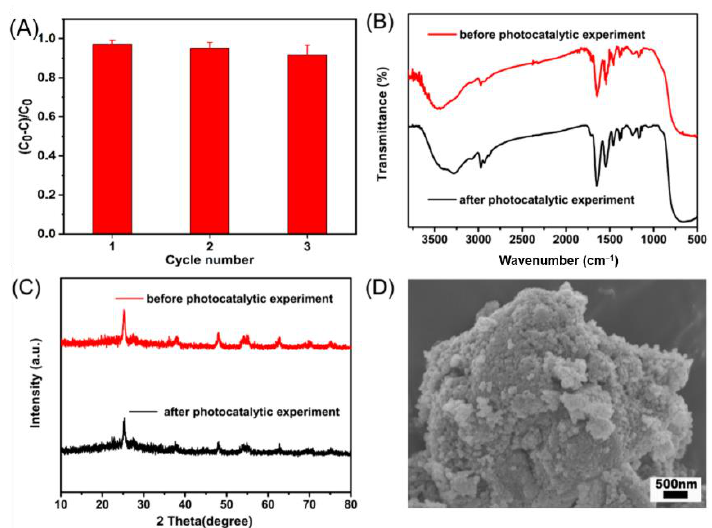
Figure 7. Photocatalytic efficiency of ZnPc- g -TiO 2 - g -PNIPAM (0.3 g/L) for the RhB (4.8 mg/L) removal of three cycles under visible light in 40 min at 20 ◦ C ( A ), FT-IR ( B ), XRD ( C ) and SEM ( D ) of ZnPc- g -TiO 2 - g -PNIPAM after the photocatalytic reaction.